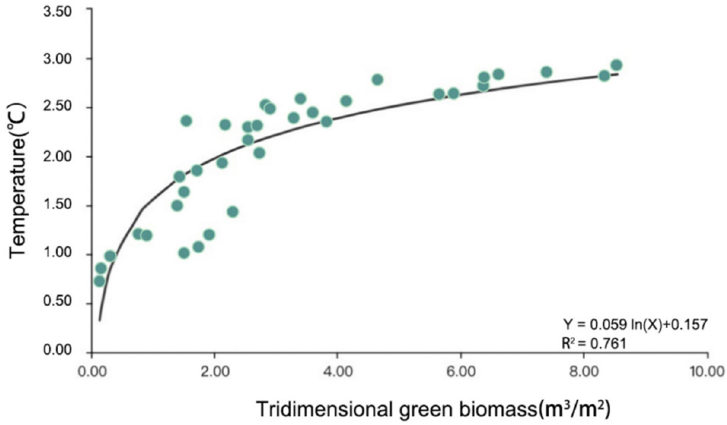
Figure 5. Relationship between temperature and tridimensional green biomass.